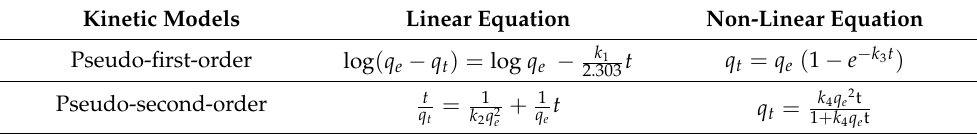
Table 1. Kinetic equations of linear and nonlinear pseudo-first-order as well as pseudo-second-order models. Kinetic Models